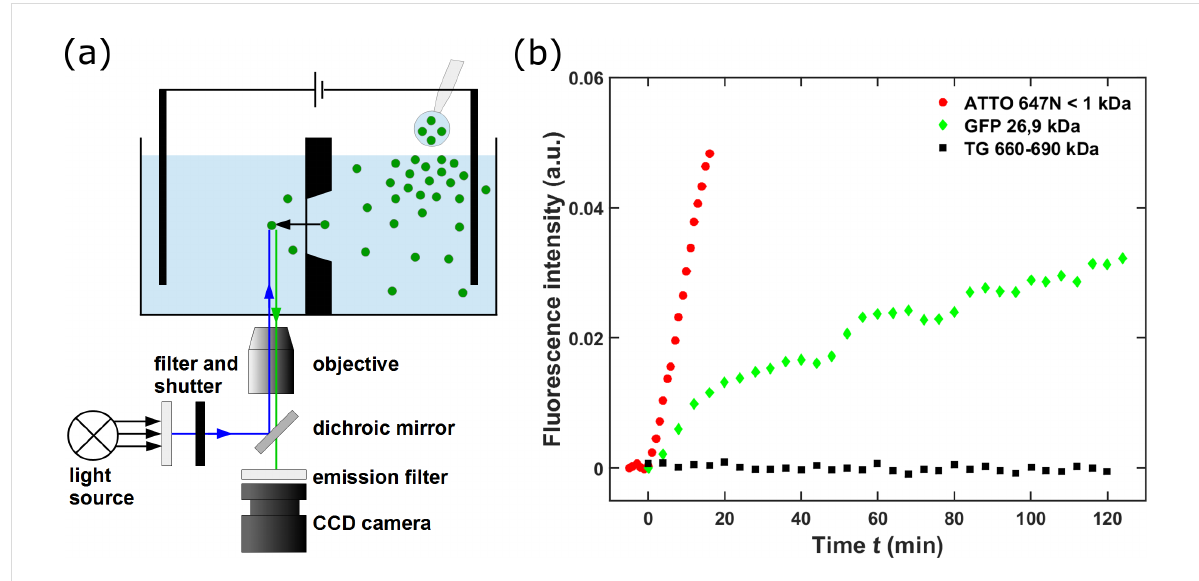
Figure 5: Molecule transport through a porous membrane of type C measured by fluorescent microscopy. (a) Experimental setup, schematically. First a mixture of green GFP and ATTO-labeled TG was applied to the cis fluid reservoir. (b) Emitted intensities of translocated molecules can only be ob- served for GFP, the larger and heavier TG molecules remain completely in the supply reservoir. After 120 min, the dye molecule ATTO is added and observed instantly behind the